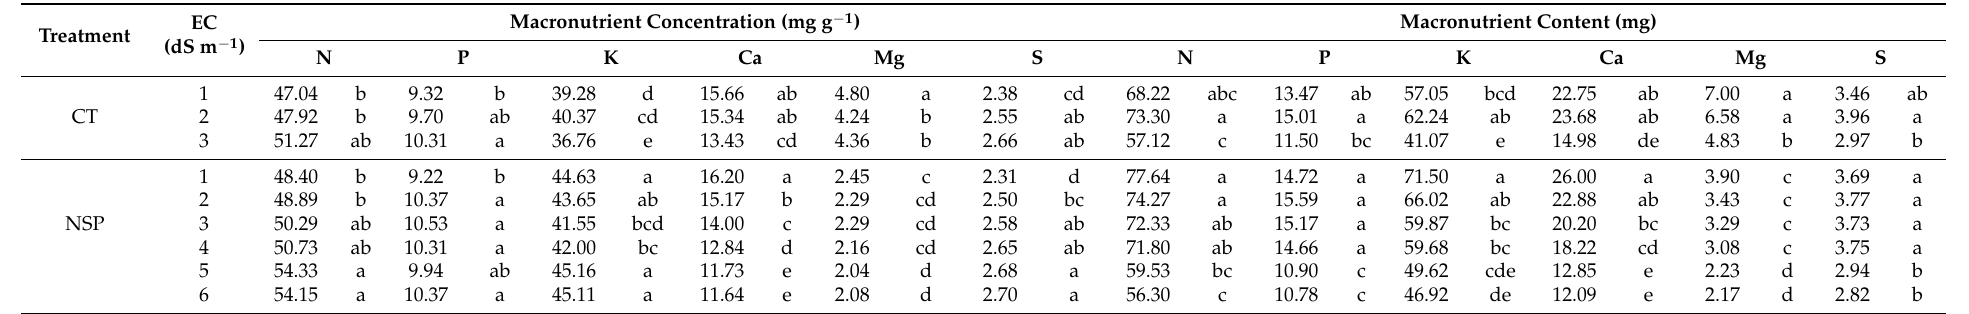
Table 3. Micronutrient content of red perilla plants grown under various EC levels of greenhouse nutrient solution (CT) and the newly-developed nutrient solution for red perilla (NSP) after 7 weeks of transplanting. Different letters within the columns indicate significant differences by Duncan’s multiple range test at p ≤ 0.05 ( n = 6).